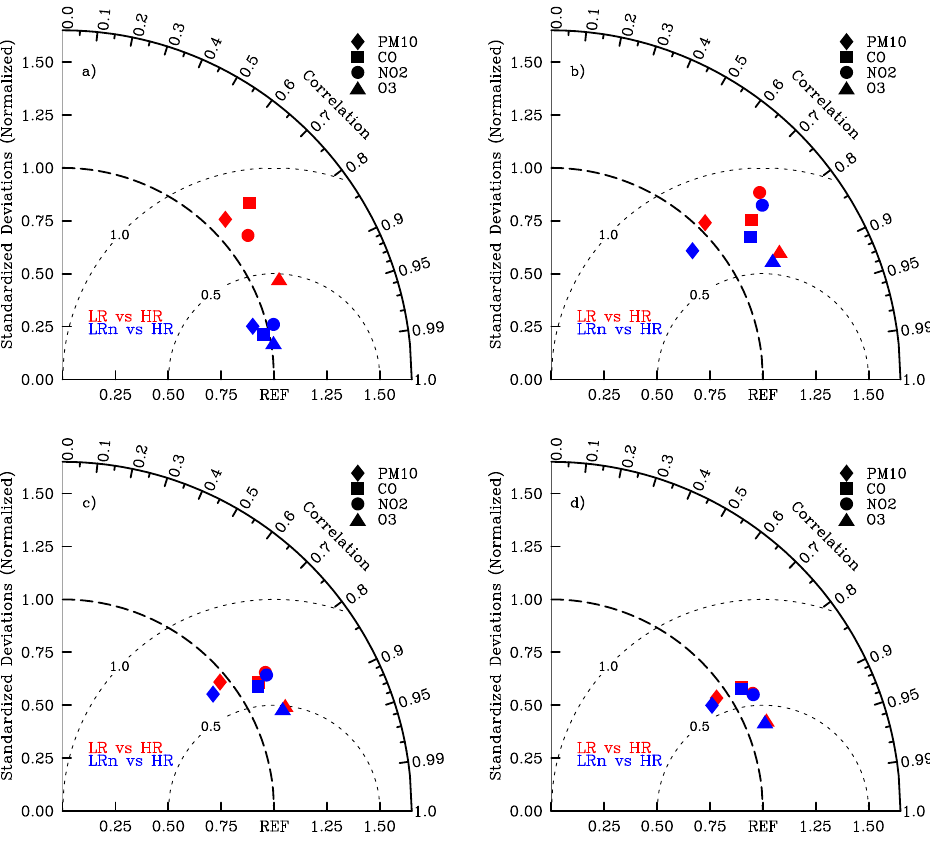
Fig. 5. Frequency distribution of the Index of Improvement for each species and for each frame. The dataset shown here includes the entire year of data.